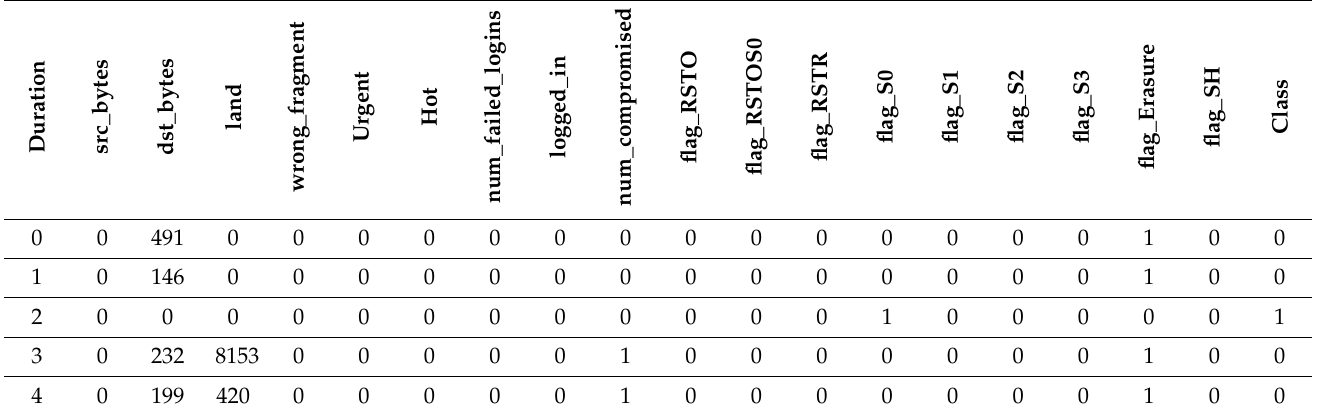
Table 10. Erasure Coding after Training